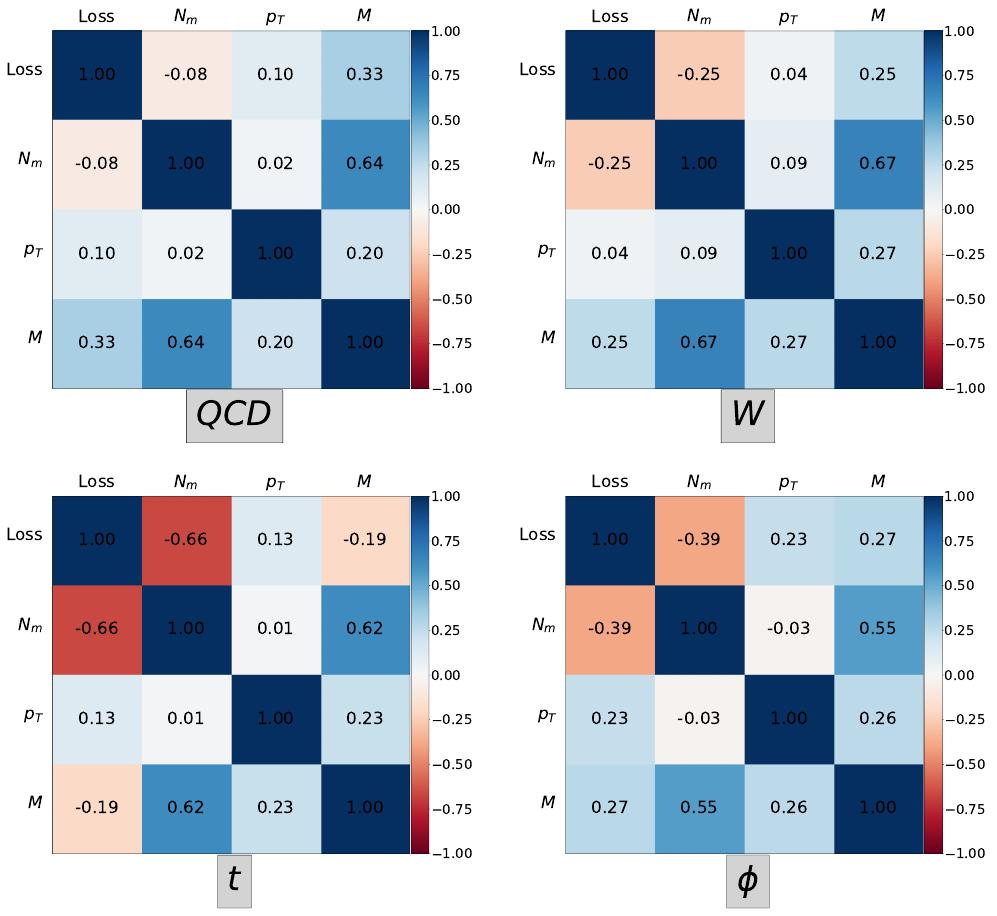
Figure 9 . Linear correlation coeeficient between the loss, number of microjets( N m ), transverse momentum ( p ), mass( M ) of the jet for the four jet classes: QCD(top left), W-boson (top right), T top-quark (bottom left) and φ (bottom